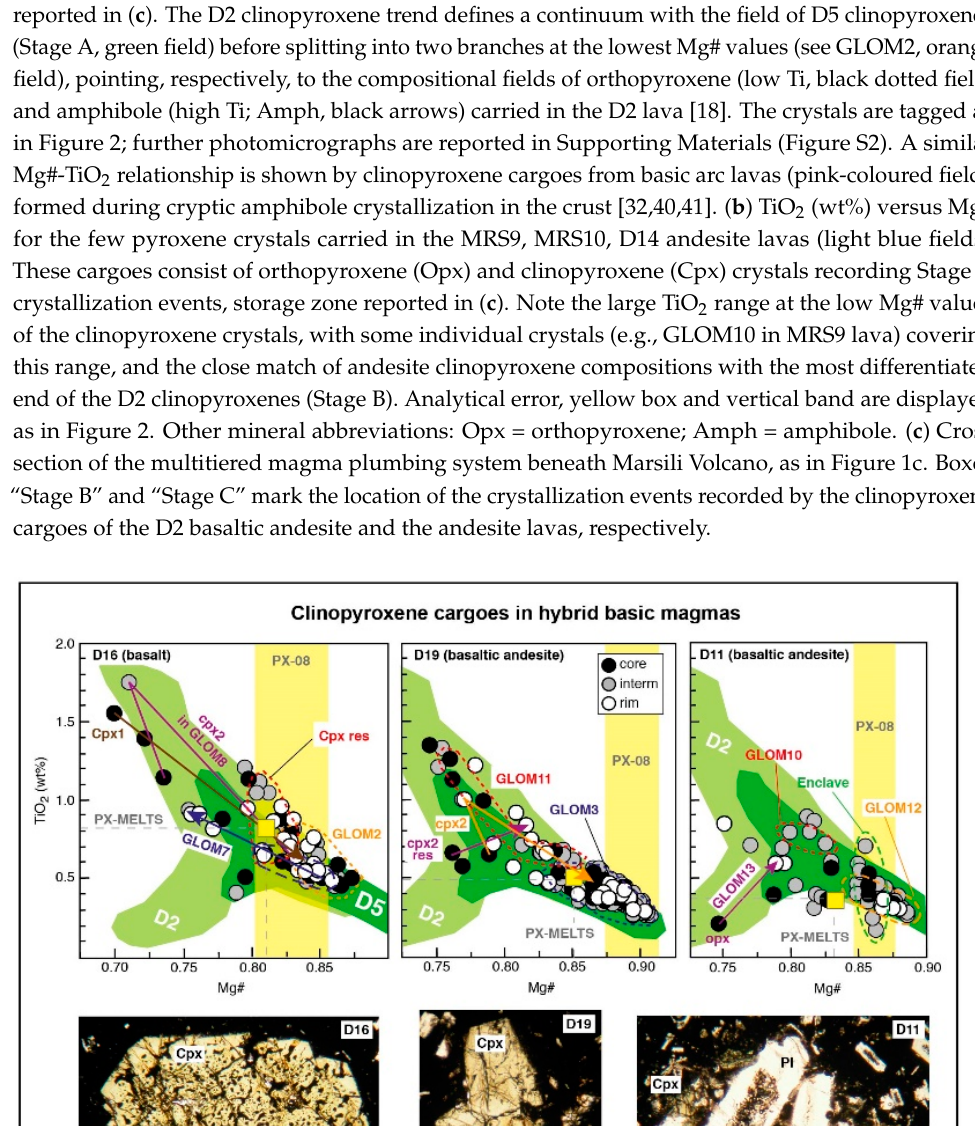
Figure 4. Plots of TiO 2 (wt%) versus Mg# for the clinopyroxene cargoes in the D16 basalt and D11 and D19 basaltic andesites. These are hybrid basic lavas erupted at the MV south-eastern flank (Figure 1a). Note that these cargoes display a similar chemical variability, irrespective of the chemistry of the carrier lava, that covers most of the D5 and D2 fields. The crystals are tagged as in Figure 2; further photomicrographs are reported in Supporting Materials (Figures S3 and S4). Only in these lavas, partially resorbed clinopyroxene crystals (Cpx res) and gabbroic clots with open, sub-circular texture (Enclave) were found. Analytical error, yellow box and vertical band are displayed as in Figure 2. Light and dark green fields represent D2 and D5 clinopyroxenes, respectively, recording Stage A and Stage B crystallization in the deep MV mush.